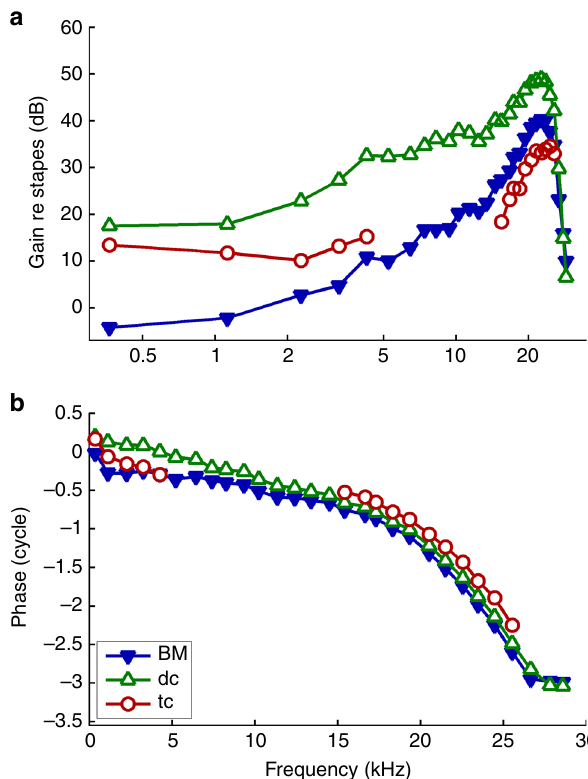
Fig. 5 Tuning characteristics of the vibration hotspot and adjacent structures. a Amplitude- and b phase-transfer functions evaluated at three locations in the living organ of Corti: fi lled triangles, near the junction between the arcuate and pectinate zones of the BM; open triangles, in the Deiters ’ cell (dc) bodies near the center of the vibration hotspot, ~40 µ m away from the BM; and circles, in the Hensen ’ s/tectal cell (tc) region ~50 µ m lateral to the Deiters ’ cells. Gain and phase are referenced to the stapes vibrations evoked by identical multi-tone stimuli. Preparation RG17805, CF 25 kHz (see Fig. 6). Stimulus level 50 dB